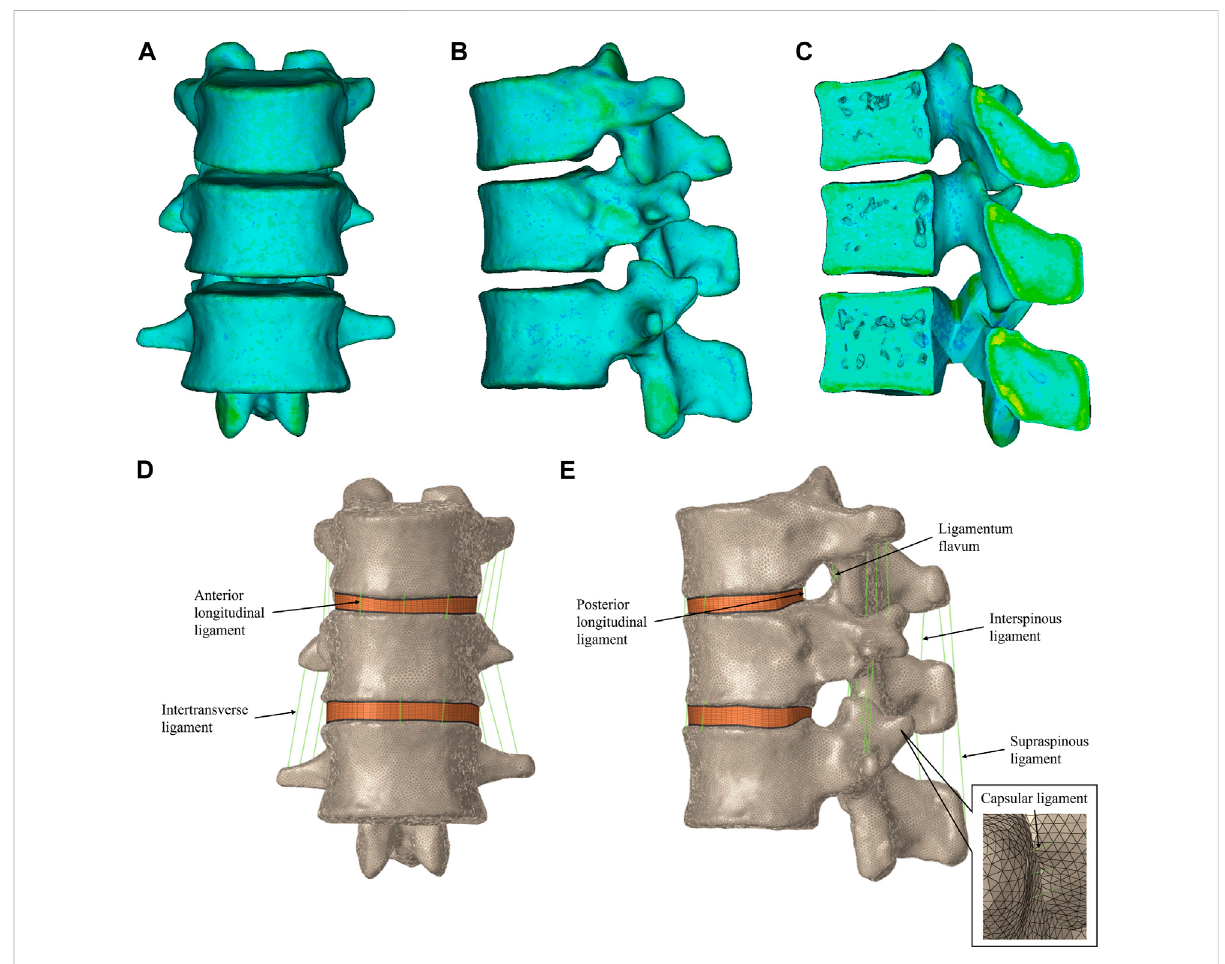
FIGURE 1 T11-L1 heterogeneous assignment fi nite element model. (A) Frontview of the T11-L1 model. (B) Left view of theT11-L1 model. (C) Section view of the T11-L1 model. T11-L1 heterogeneous assignment fi nite element model in HyperMesh, including the intervertebral disc and ligament structures. (D) Front view of the T11-L1 model. (E) Right view of the T11-L1 model.